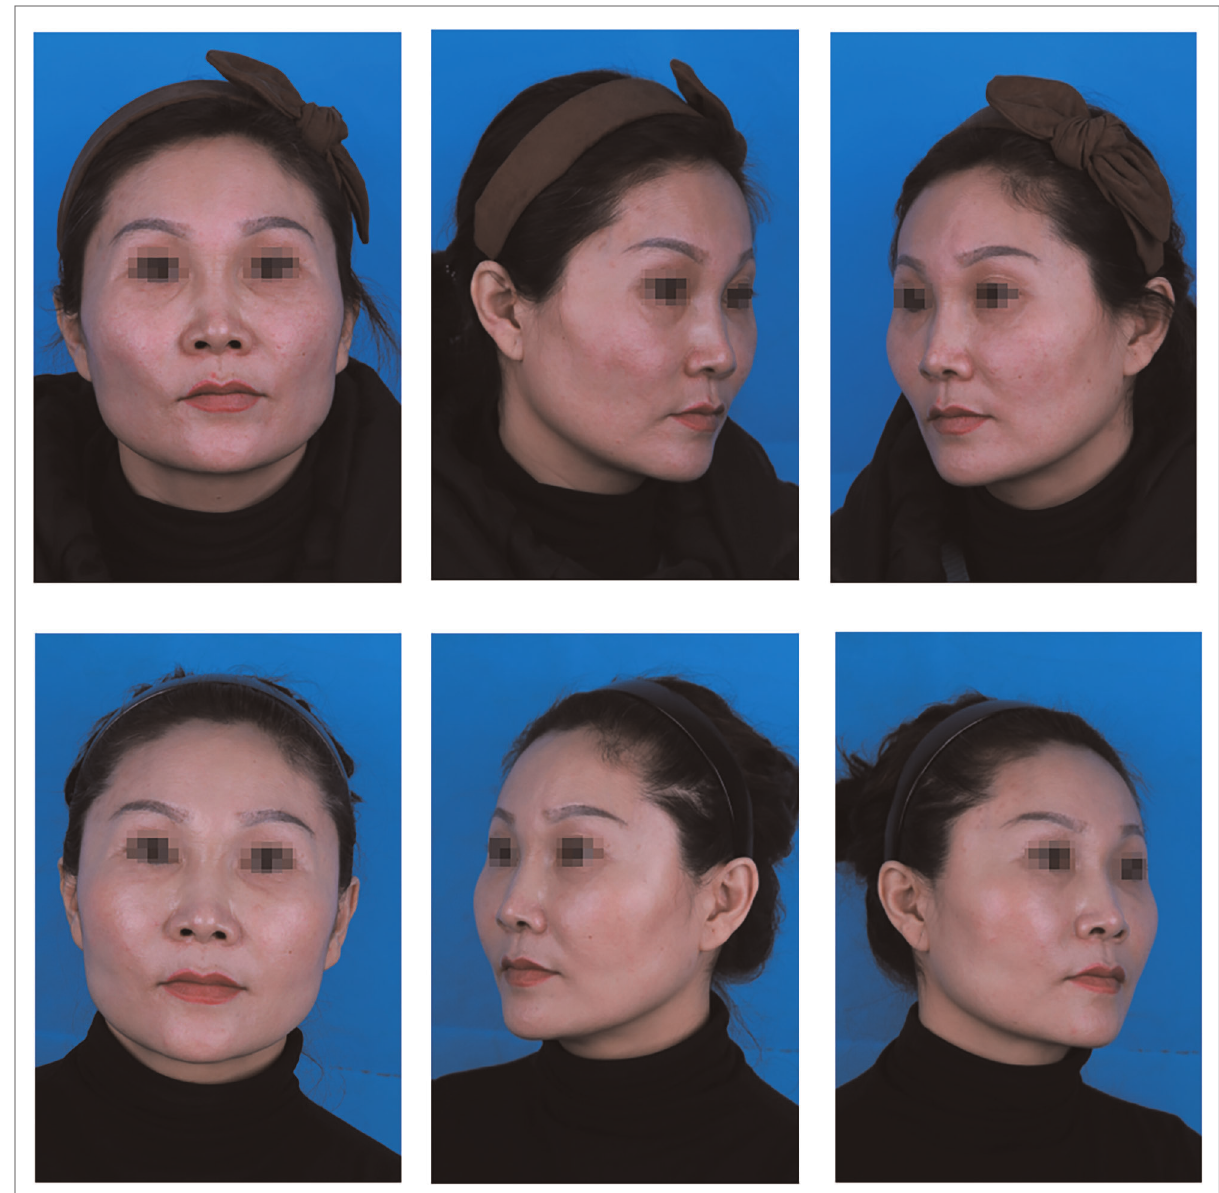
FIGURE 2 A 43-year-old patient: (top) preoperative view; (bottom) postoperative view 12 months after fat graft combined with PRF to the cheek, nasojugal folds and temporal regions, and 12, 5, and 24 ml of PRF-assisted fat were lipotransferred into each region (bilateral),